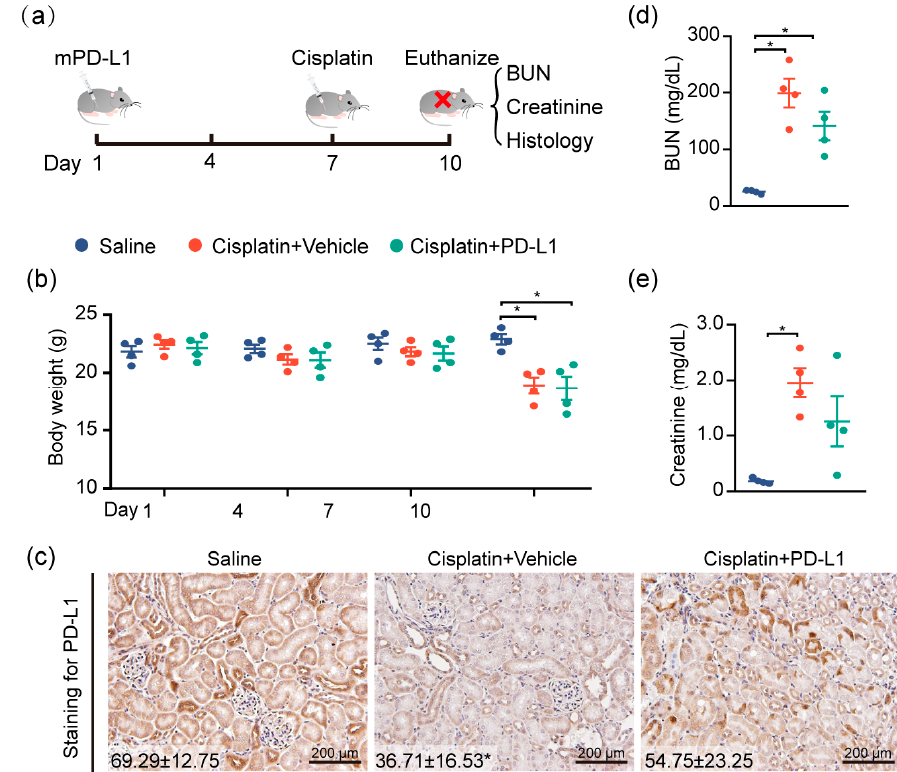
Figure 5. Targeting PD-L1 protects against AKI. PD-L1-containing lentiviruses were delivered into the kidneys of mice through subcapsular injection. Seven days after injection, mice were intraperitoneally treated with 30 mg/kg cisplatin for 72 h, and body weights and blood sera were collected at the end of the study, at 10 days. ( a ) Study timeline. ( b ) Body weights of mice throughout the duration of the experiment. ( c ) Representative images of IHC staining using anti-PD-L1 antibody ( n = 4; mean ± SD). ( d ) The levels of serum BUN and ( e ) creatinine were determined ( n = 4; * p < 0.05).